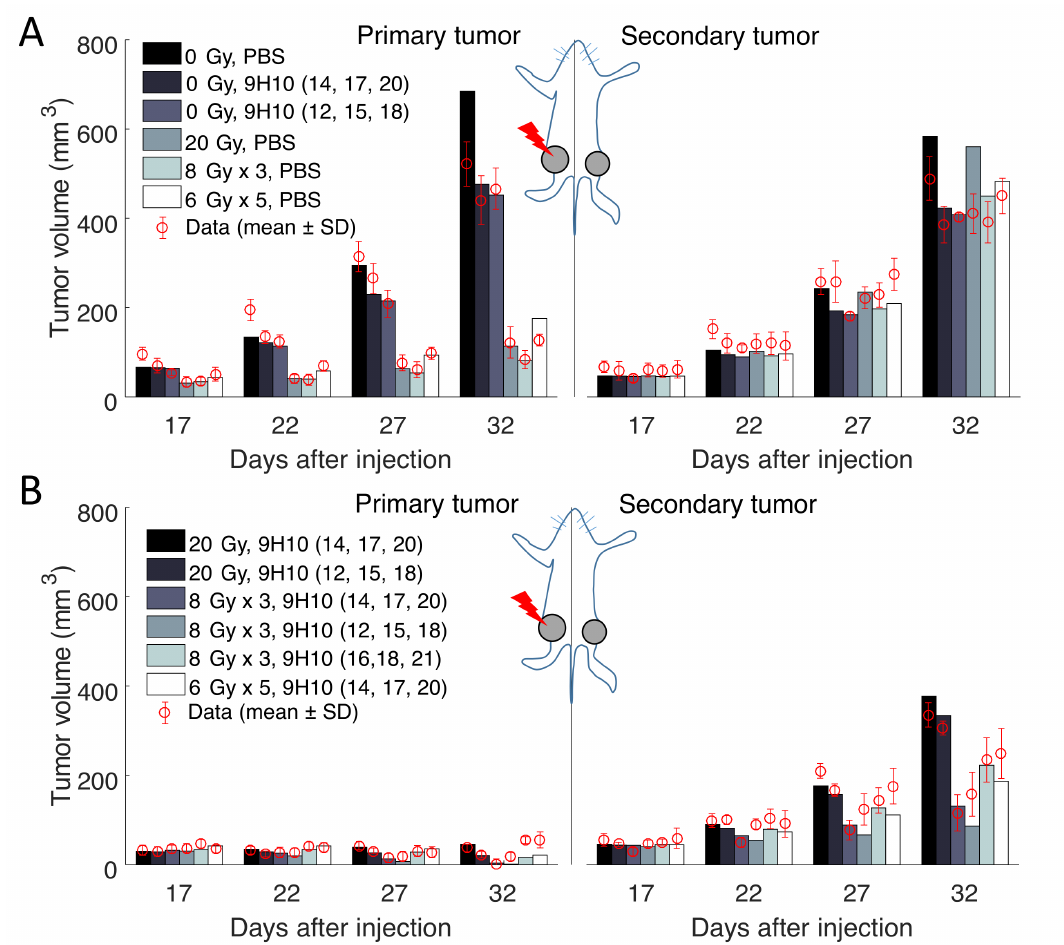
Figure 2. Comparison of the model simulated growth dynamics with experimental data. Solutions to the proposed model (Equations (3)–(10)) were obtained after performing data fitting (estimated parameters are presented in Table 1). ( A ) Experimental and simulated tumor volumes for tumors grown without treatment or after monotherapy. ( B ) Experimental and simulated tumor volumes after combination treatment. Experimental data (red circles) derived from Dewan et al.